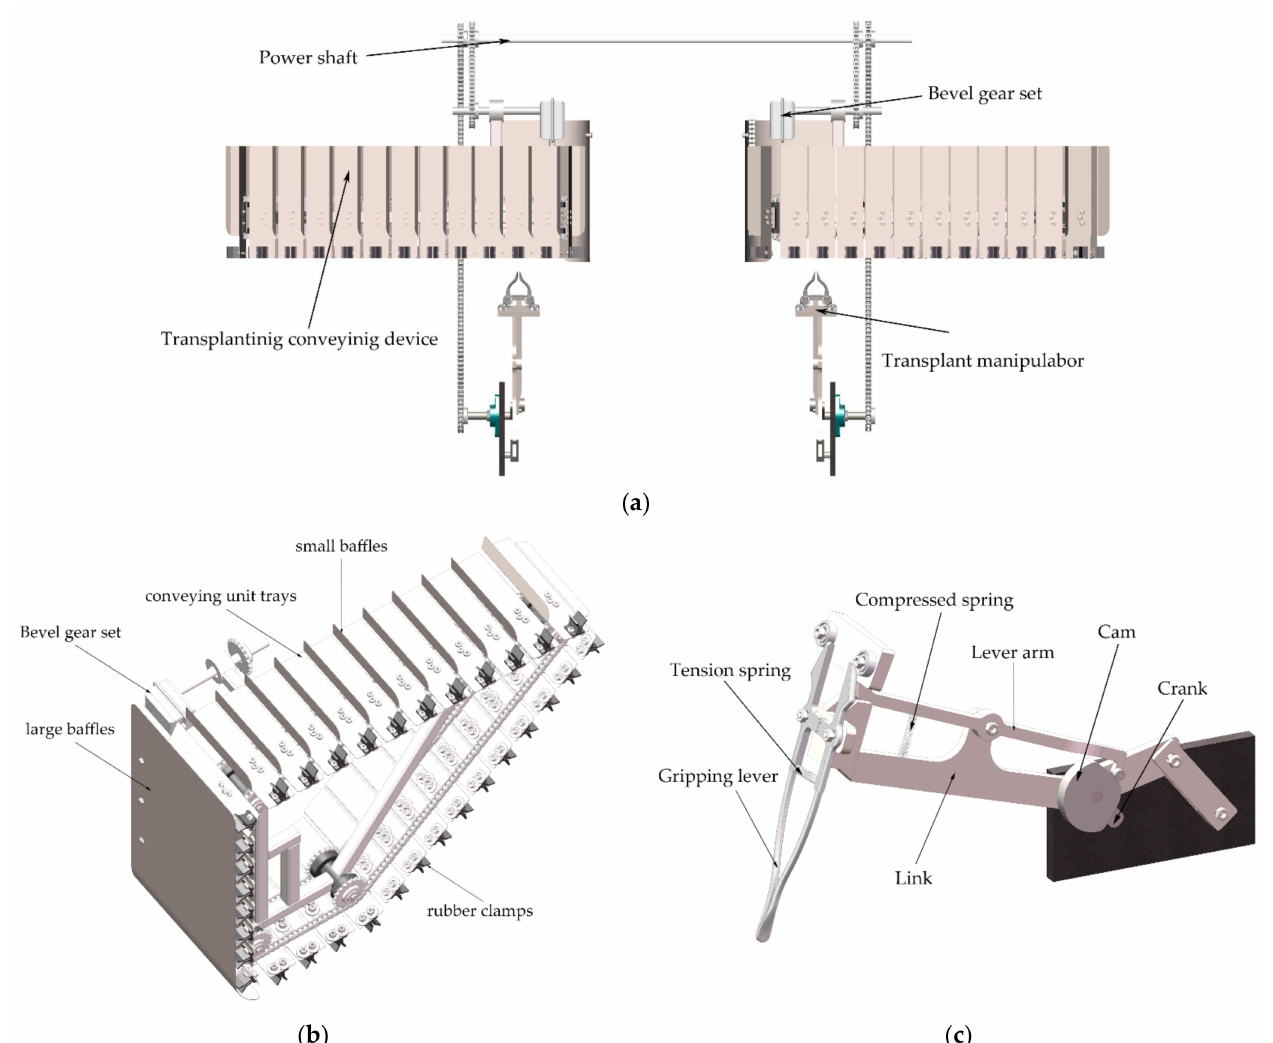
Figure 2. Working diagram of the transplanting device. ( a ) Top view of transplanting device, ( b ) transplanting conveyor device, and ( c ) transplanting manipulator.